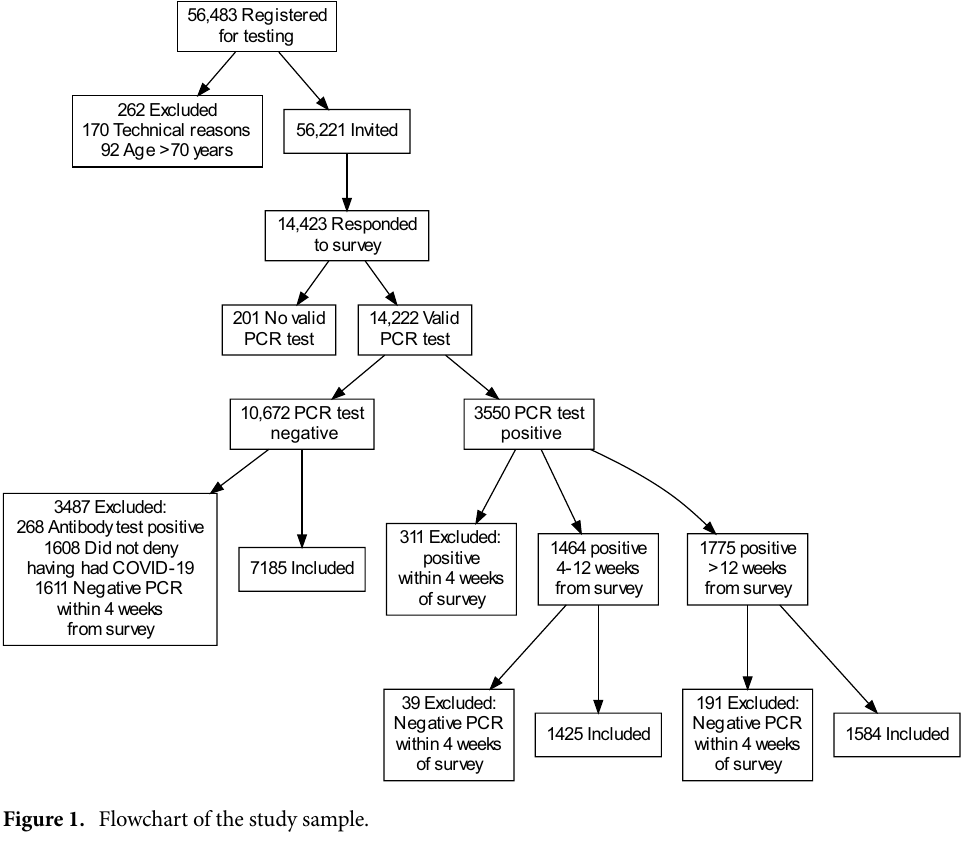
Figure 1. Flowchart of the study